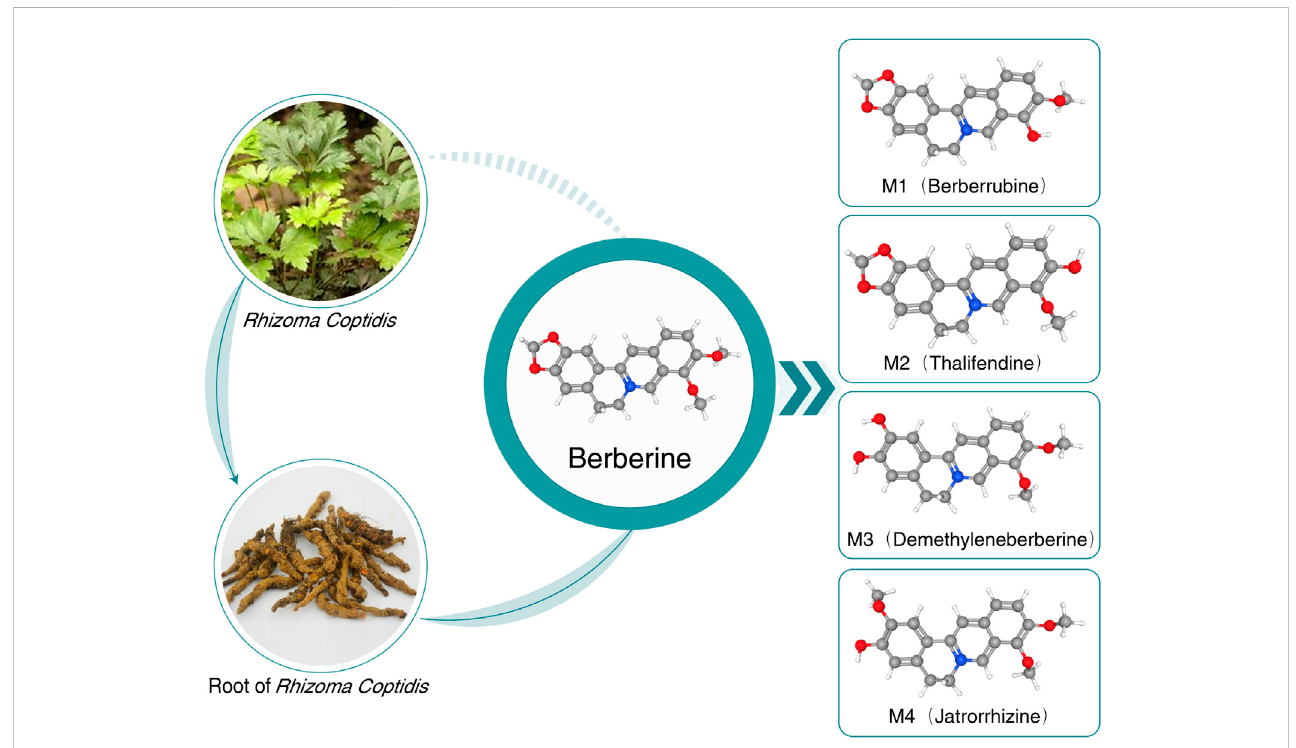
Chemical structure and metabolites of BBR. BBR, berberine; MetS, metabolic